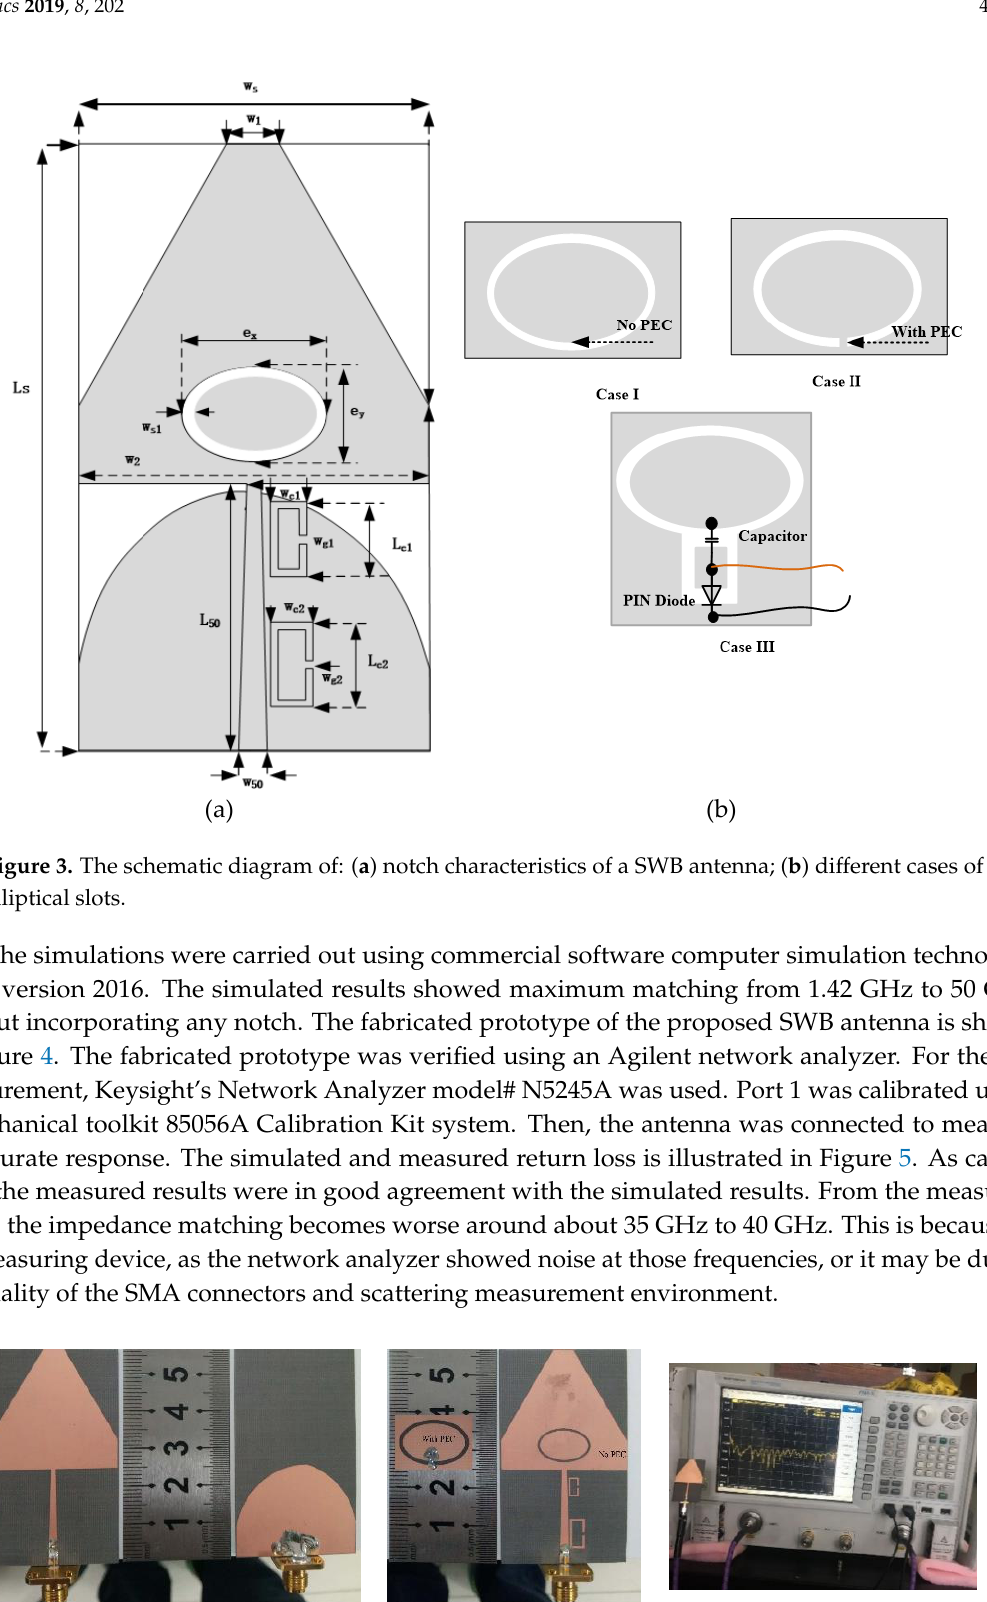
Figure 5. The simulated and measured return loss. Figure 6. The simulated and measured peak gain. 0